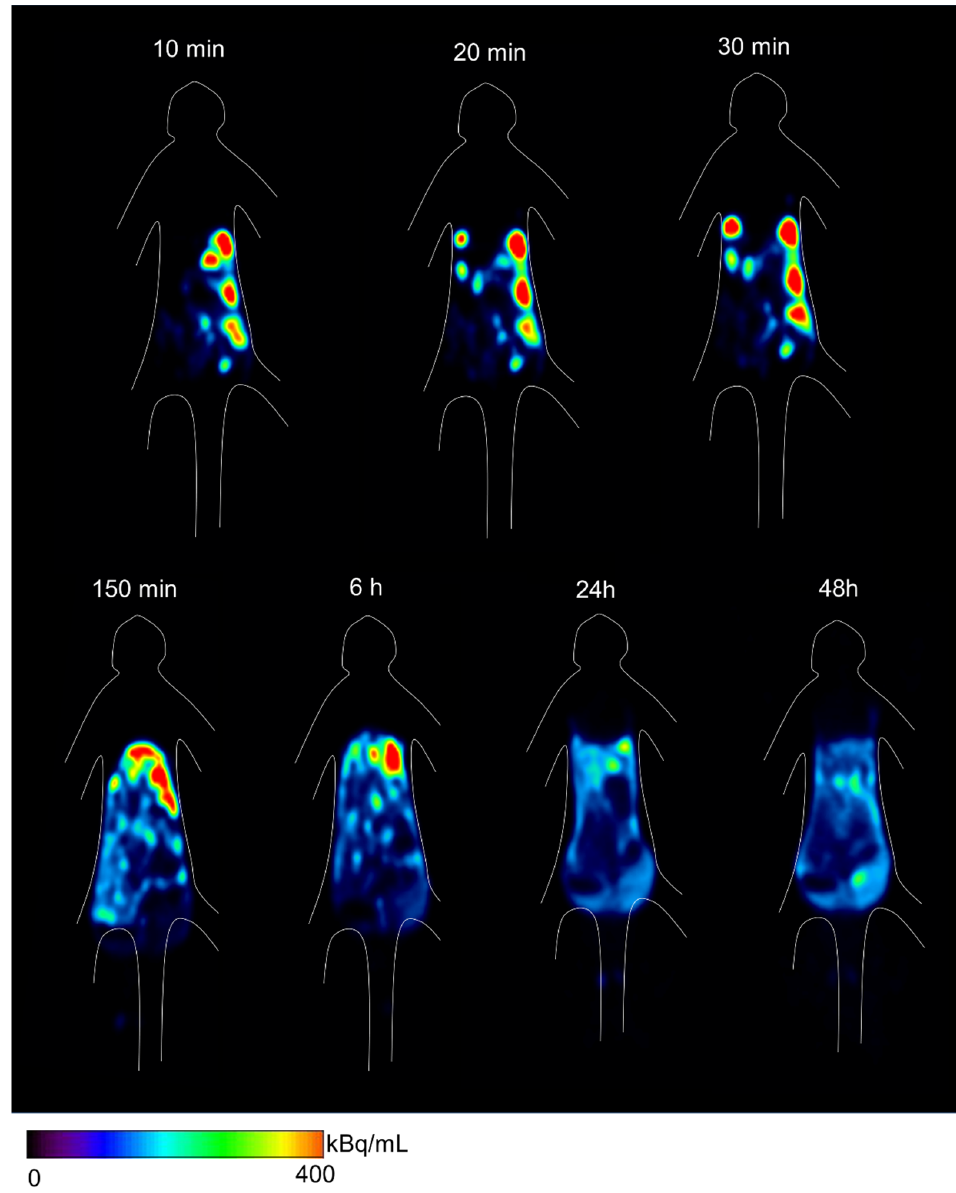
Figure 5. Positron emission tomography (PET) images of distribution of 64 Cu-NCAB001 radioactivity in a representative monkey at different time points after intraperitoneal administration. Representative PET images with coronal view containing pancreas.